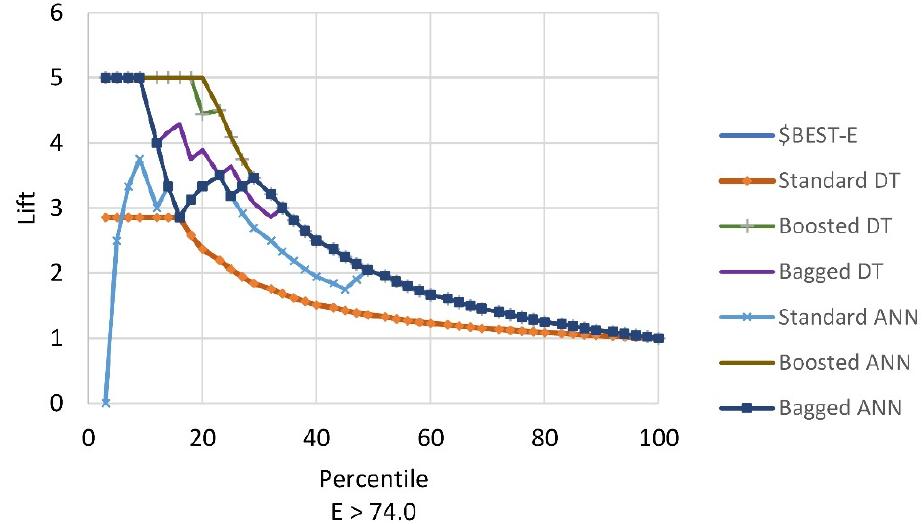
Figure 8. Lift chart of the models developed in this study.